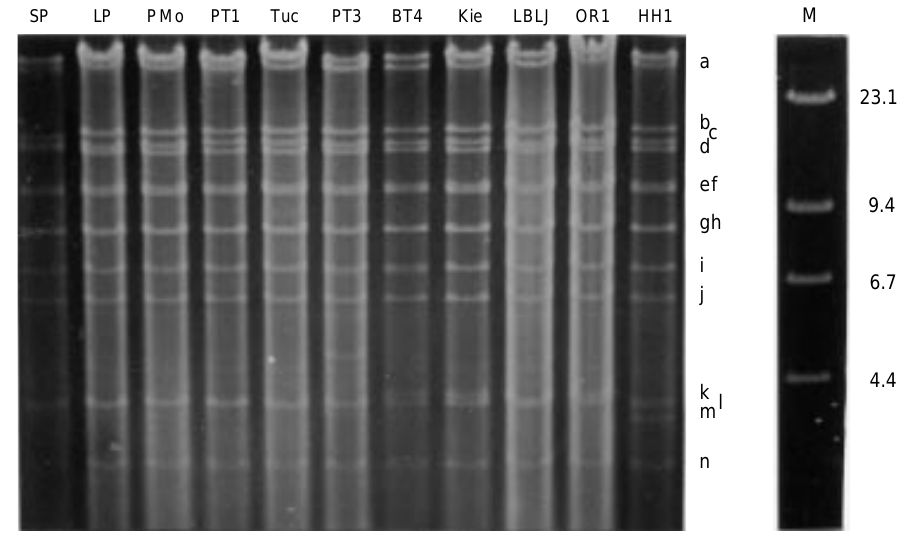
Figure 2 - Restriction fragment obtained with BglII from 10 EHV- 1 strains isolated in Argentina from 1979 to 1991. M: Molecu- lar weight marker fragments ( l DNA HindIII digested) are re- ported as kilobases. Fragment nomenclature is shown on the right according to the report for the HH1 strain